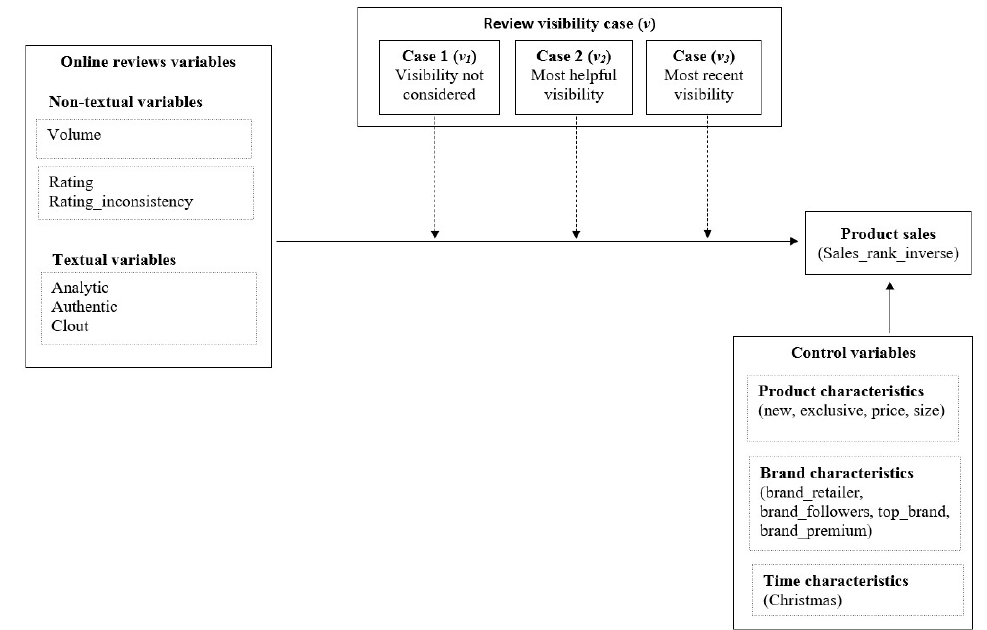
Figure 1. Conceptual Model.